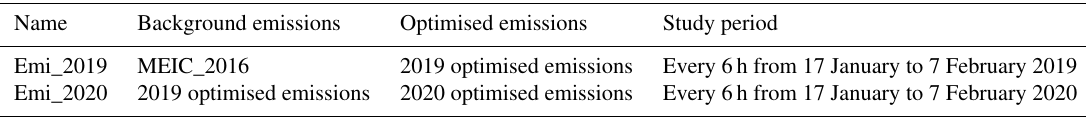
Figure 4. Flow chart of the SO 2 emissions optimisation procedure in a single time step of i . The orange boxes represent the SO 2 -optimised emissions and SO 2 concentrations of output. The c b Table 2. Details of 4DVAR experiments to optimise emissions for 2019 and